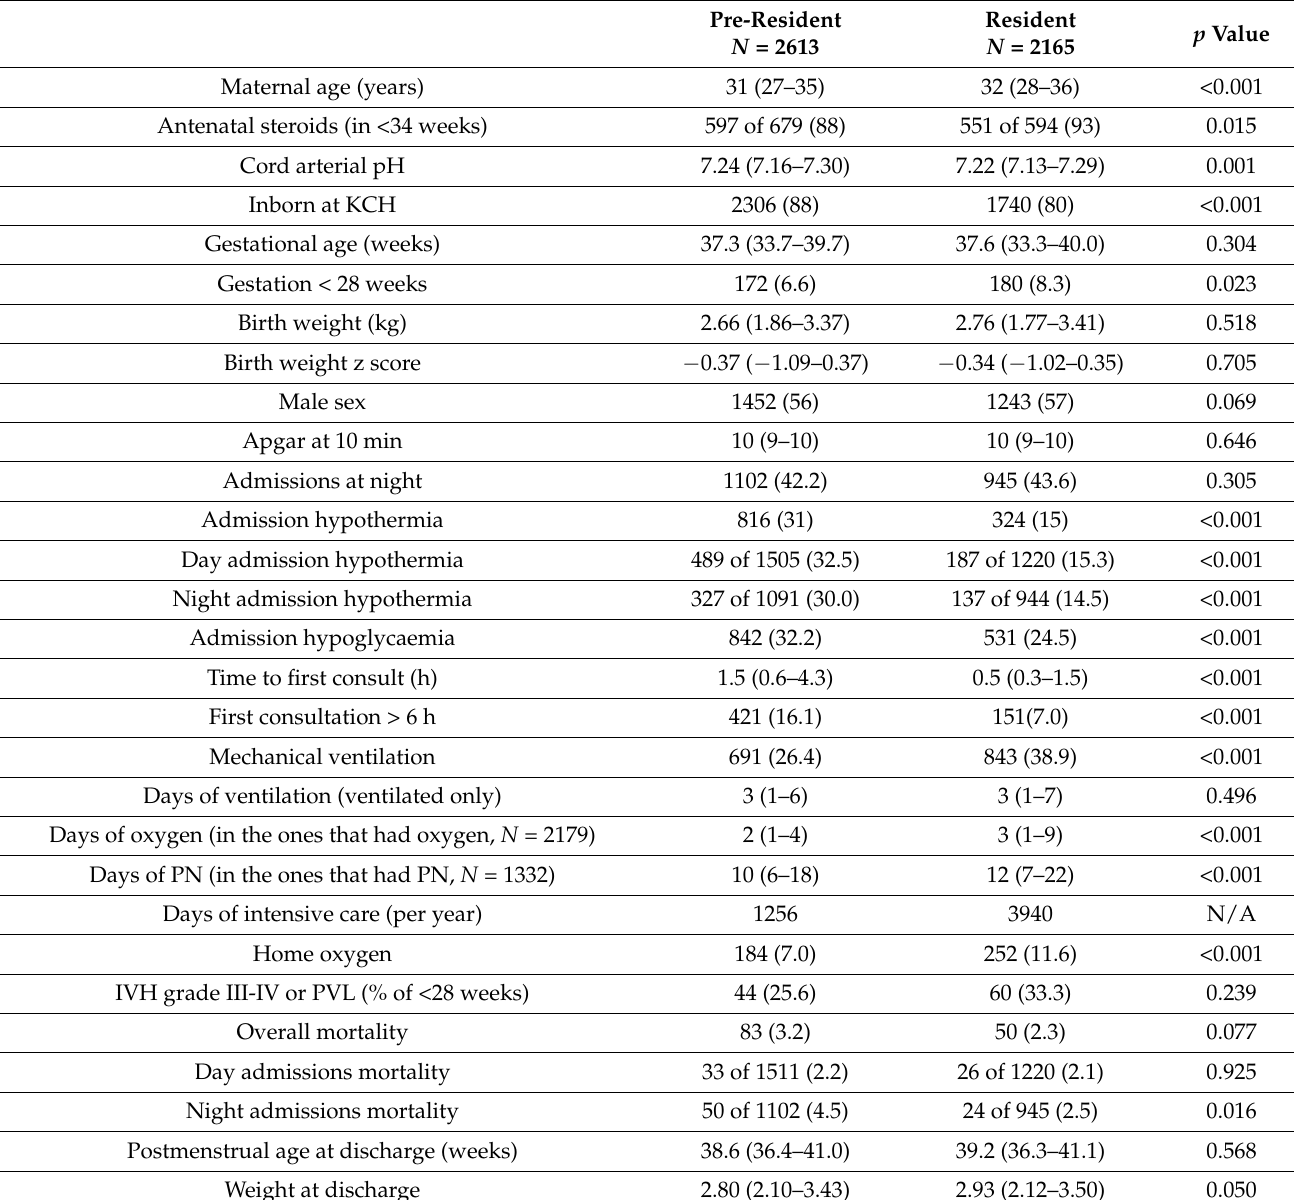
Table 1. Characteristics and outcomes of the admitted infants in the two study periods. Median (IQR) or N (%). Comparisons by Mann–Whitney U or x 2 test as